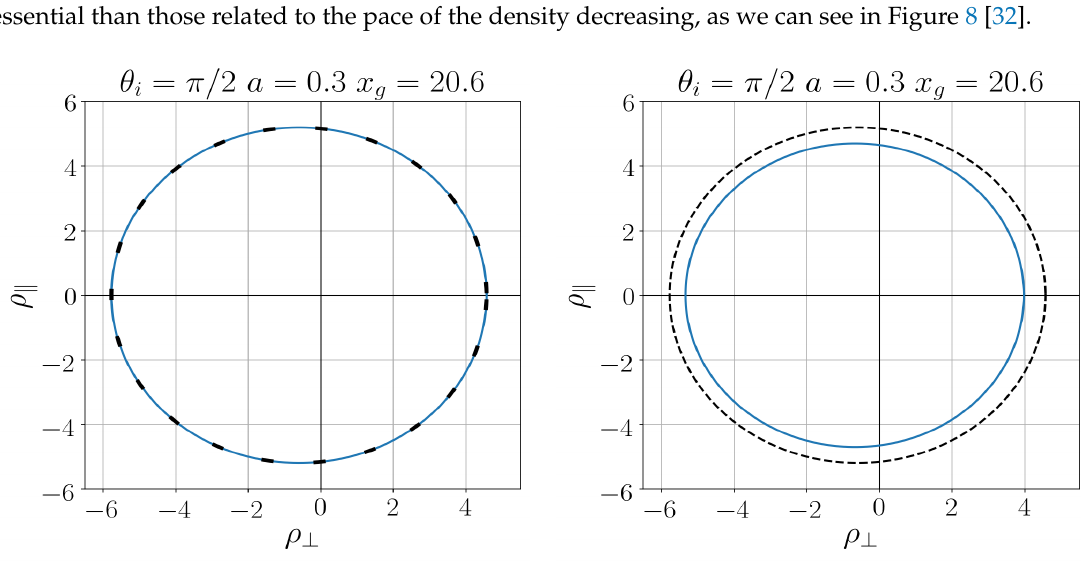
Figure 8. Comparison of shadows for the case of the density profile (7) ( Left ) and for the density profile (26) ( Right ) for a = 0.3. An observer angular coordinate θ i = π